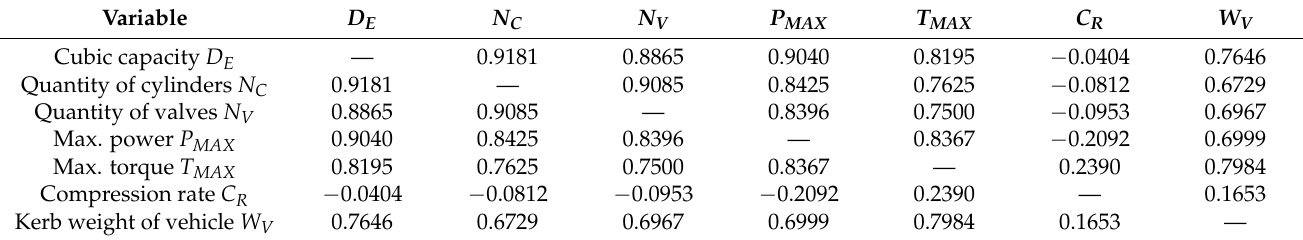
Table 4. Values of the correlation coefficient r between quantitative input